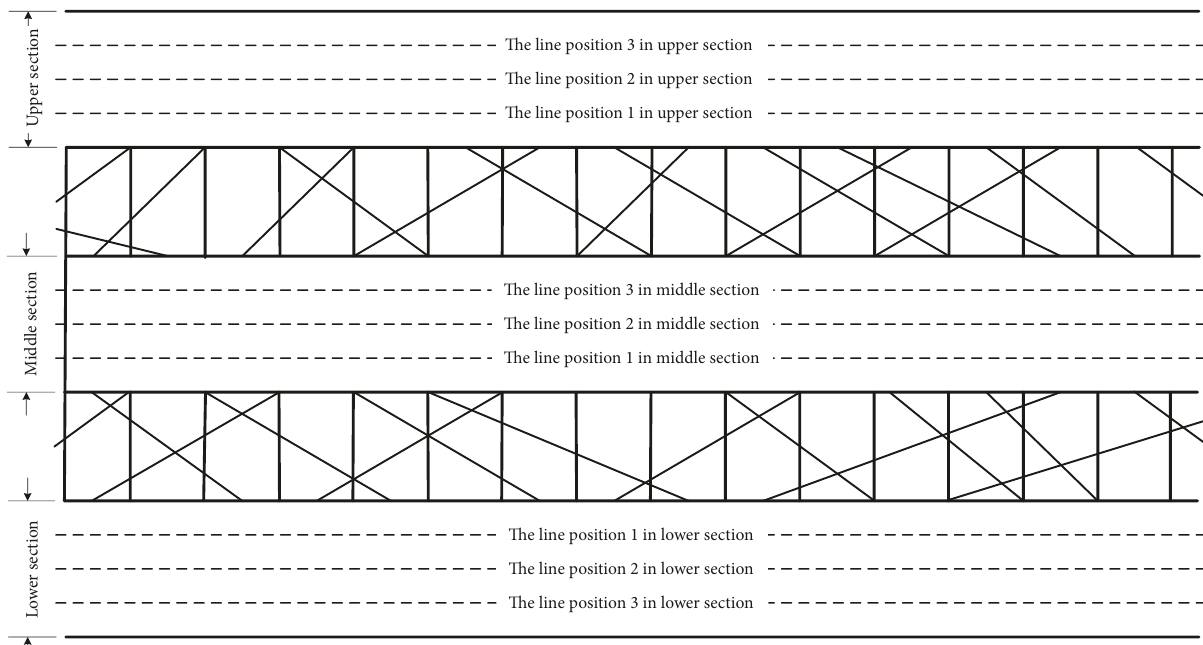
Figure 1: Line position of connection lines in the cyclic locomotive